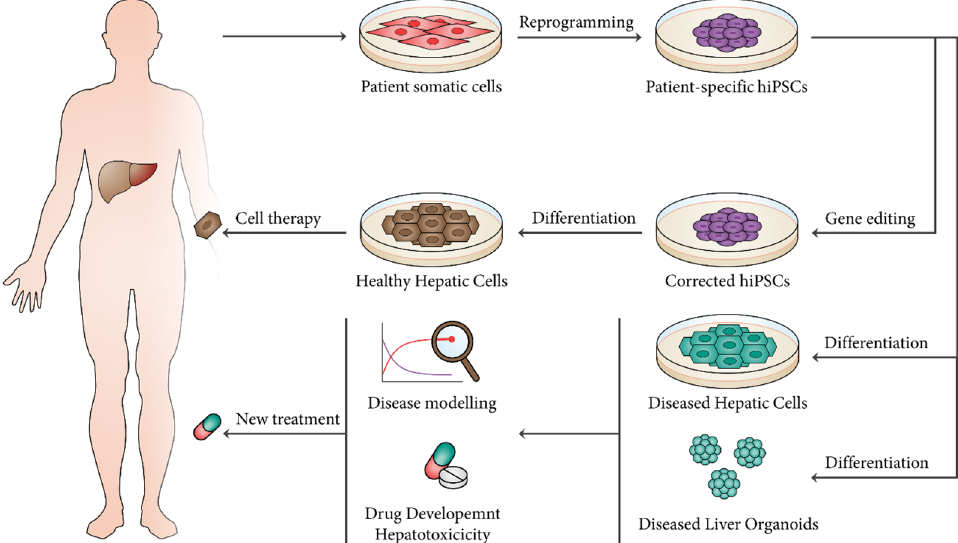
Figure 2. Clinical applications for hPSC-derived hepatic cells and liver organoids. Isolated somatic cells from patients can be cultured and reprogrammed into patient-specific hiPSCs. These cells represent a promising cell source for cell therapy, as differentiated hepatocytes can be used for transplantation in regenerative medicine strategies. Additionally, differentiated hepatic cell lineages or generated liver organoids can be applied in disease modelling, as well as drug development and hepatotoxicity assays.